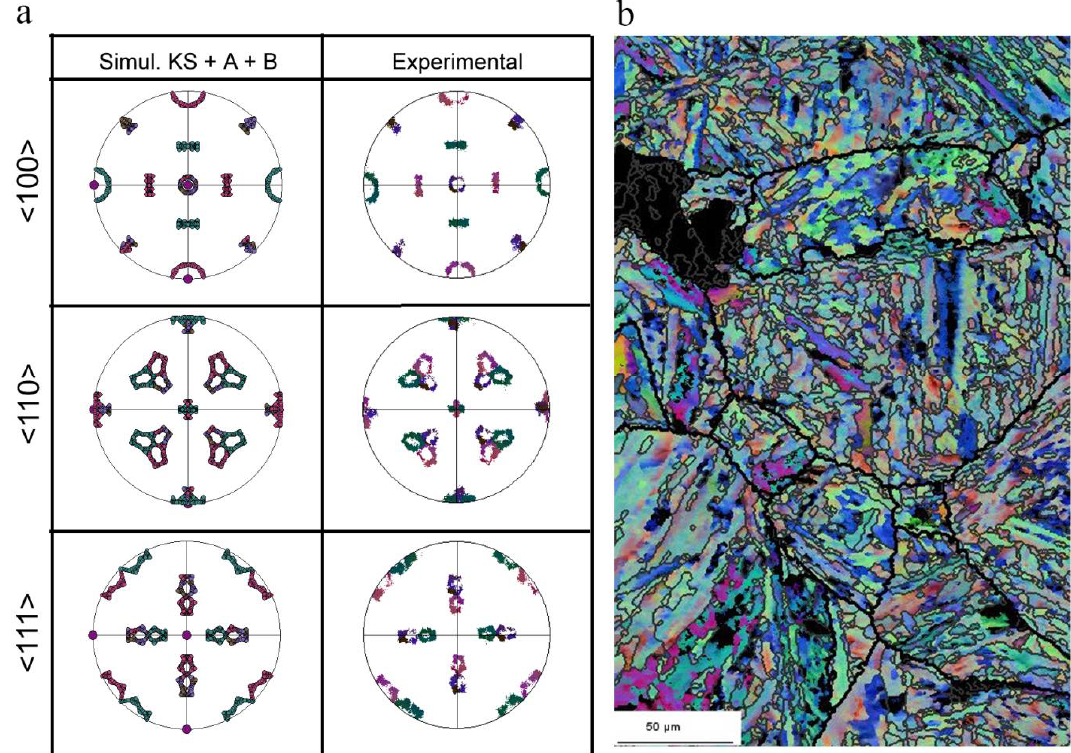
Figure 19. Continuous gradients of orientations inside bcc martensitic grains. ( a ) Simulations of the pole figures made with 24 KS variants and two rotations A and B , with angular range 0–5° (left column), compared to the experiments (right column), from [114]; ( b ) RGB coloring of the Pitsch, KS, and NW ORs inside the martensitic grains of the EMT10 steel shown in 0. Reprinted from [115] with permission from Elsevier.